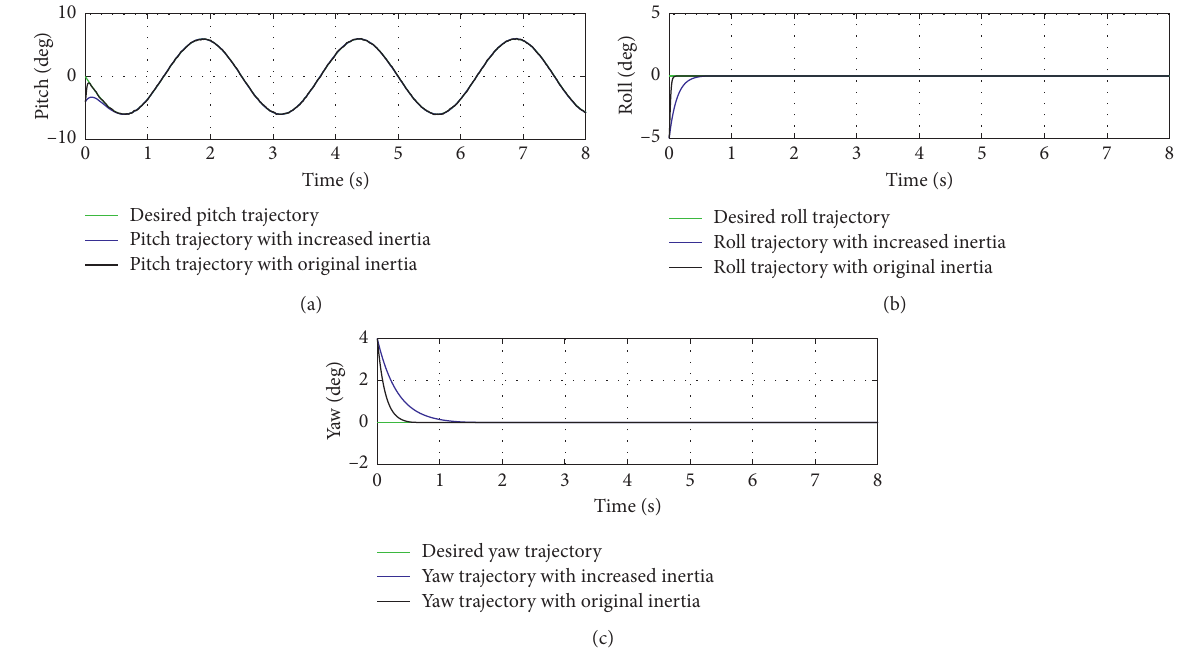
Figure 11: Tracking performance of increased moment of